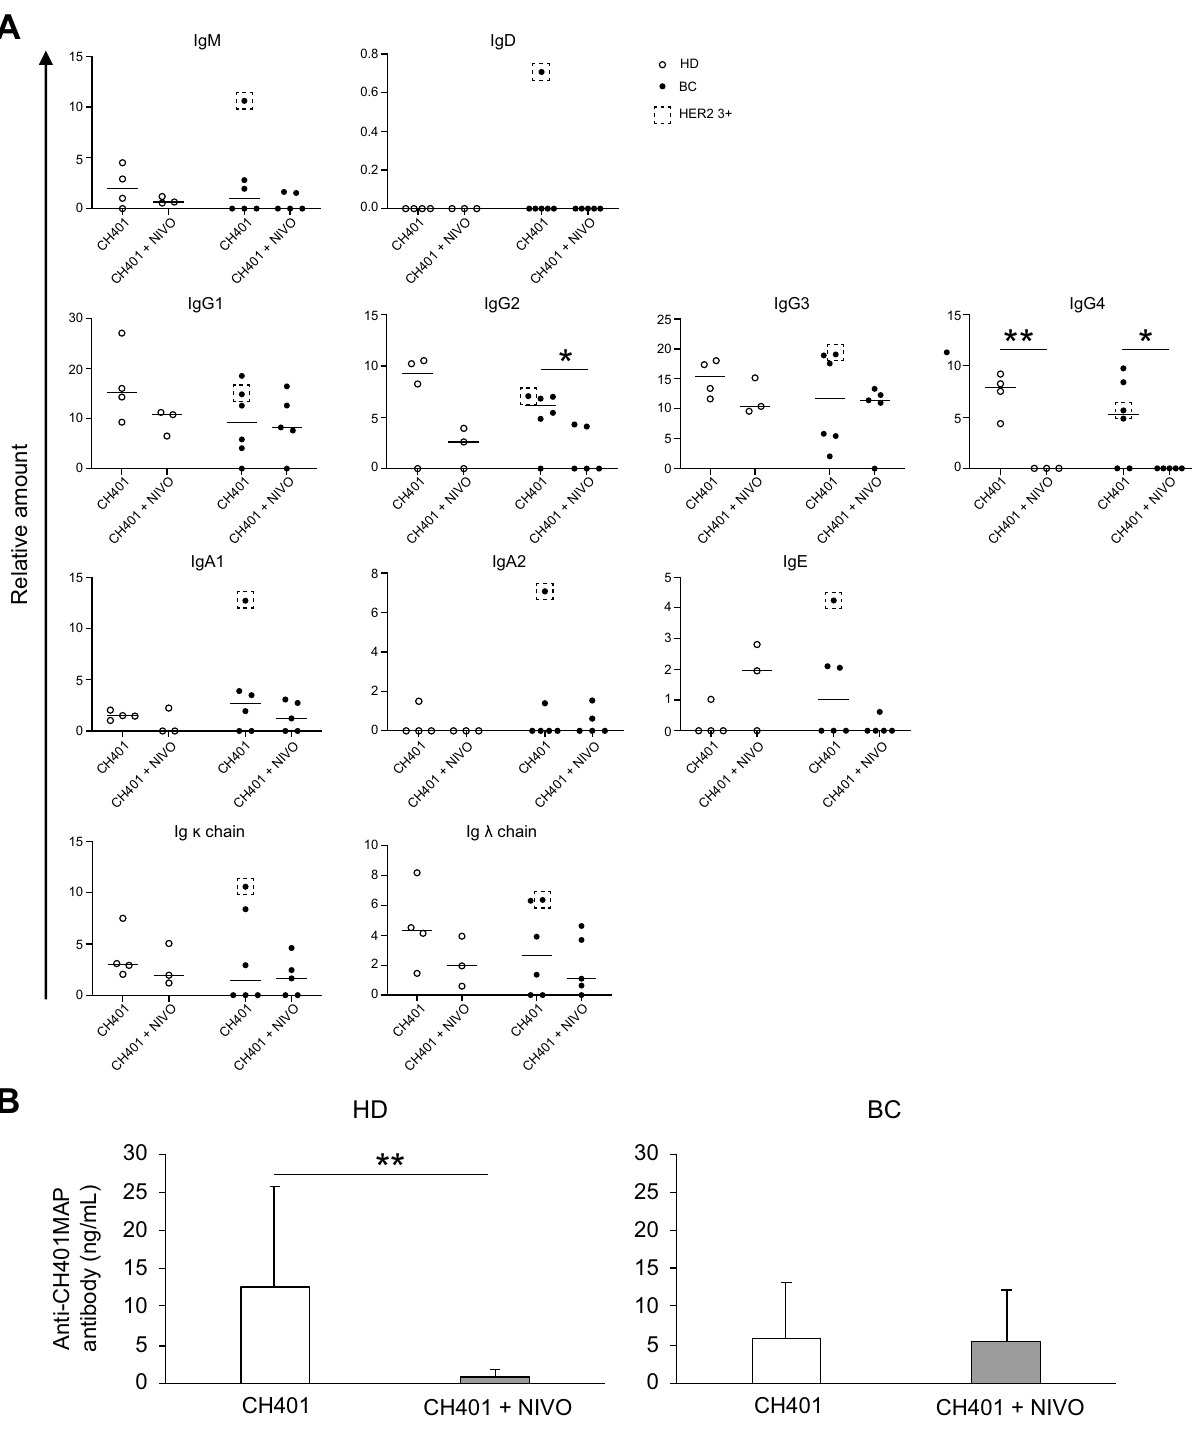
Figure 7. Effects of nivolumab on antibody production by human B cells. (A) Relative amount of each human antibody class in HD-transplanted (open circle; CH401MAP; n = 4, CH401MAP + NIVO; n = 3) or BC-transplanted (filled circle; CH401MAP; n = 6, CH401MAP + NIVO; n = 5) mice. HER2 3 + BC-Ms were indicated with dotted squares. * p = 0.05, ** p = 0.01. (B) Anti-CH401MAP antibody concentrations in HD- or BC-transplanted mouse plasma; CH401MAP (white bar) or CH401MAP + NIVO (gray bar) groups. ** p = 0.01. BC breast cancer; HD healthy donor; Ig